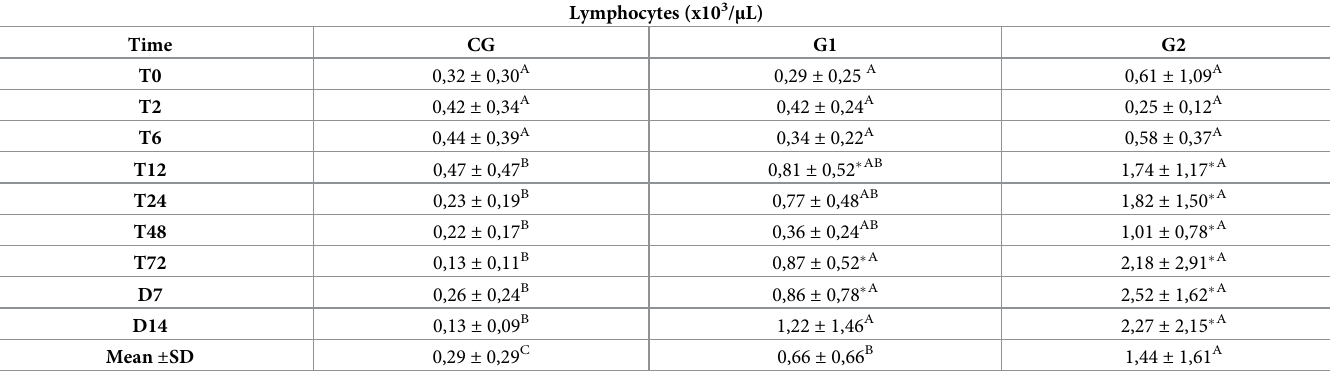
Table 4. Mean and standard deviation (SD) of lymphocytes in the peritoneal fluid of healthy horses (CG) and horses submitted to cecal trocarization with a cecal needle (G1) or a cattle trocar (G2).